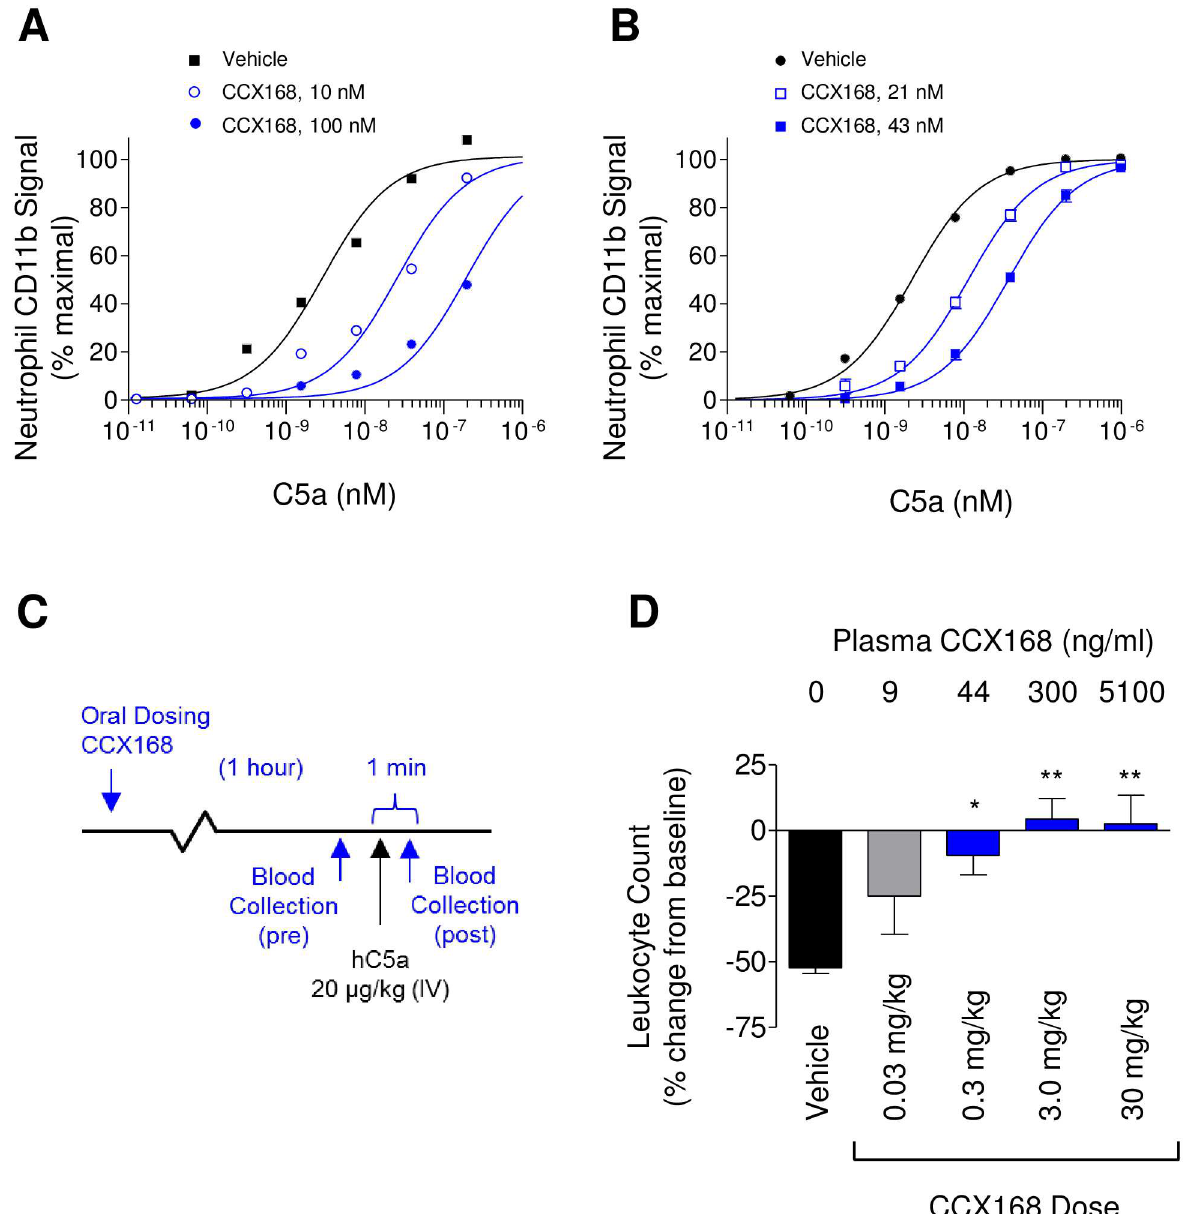
Fig 5. Biological Effects of CCX168 on Transgenic Human C5aR Knock-in Mice. (A) C5a-induced upregulationof CD11b on the surface of neutrophils in whole blood from human C5aR knock-in mice, after addition of vehicle ( ■ ), 10 nM ( (cid:14) ), or 100 nM ( ● ) CCX168. CCX168 inhibited CD11b upregulation in a dose-dependent manner. Each data point represents the mean of 3 replicates ± standard error; the study was repeated3 separate times. (B) C5a-induced upregulation of CD11b on the surface of neutrophils in whole blood from human C5aR knock-in mice 1 hour after oral dosing with vehicle ( ● ), 0.075 mg/kg ( □ ), or 0.15 mg/kg ( ■ ) CCX168. Neutrophil CD11b upregulation was diminishedin blood from CCX168-treated mice. Plasma concentrations of CCX168 are indicated. (C) Schematic of the C5a-induced leukopeniastudy in human C5aR knock-in mice. One hour followingoral administration of CCX168, C5a (20 μ g/kg) was administered intravenously, with blood drawn immediately before and 1 minute after C5a injection.Blood samples were analyzedfor leukocyte numbers. (D) Effect of CCX168 in the C5a-induced leukopeniastudy in hC5aR knock-in mice. The percent changein the number of leukocytes in the blood sample collected after C5a injection, relative to the sample collectedprior to C5a injection, is shown for each group (4 mice per group). Above each bar is the average concentration of CCX168 in the pre-injection blood samples. CCX168 inhibitedthe depletionof blood leukocytes caused by intravenousadministrationof C5a. * p < 0.05, ** p < 0.01 based on Student’s